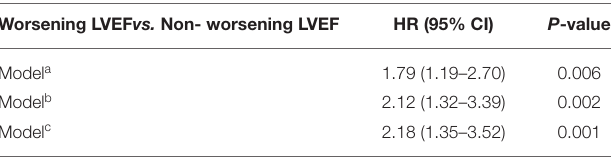
TABLE 2 | The Cox regression analysis with risk factors for all-cause mortality in patients with HFpEF. Worsening LVEF vs. Non- worsening LVEF